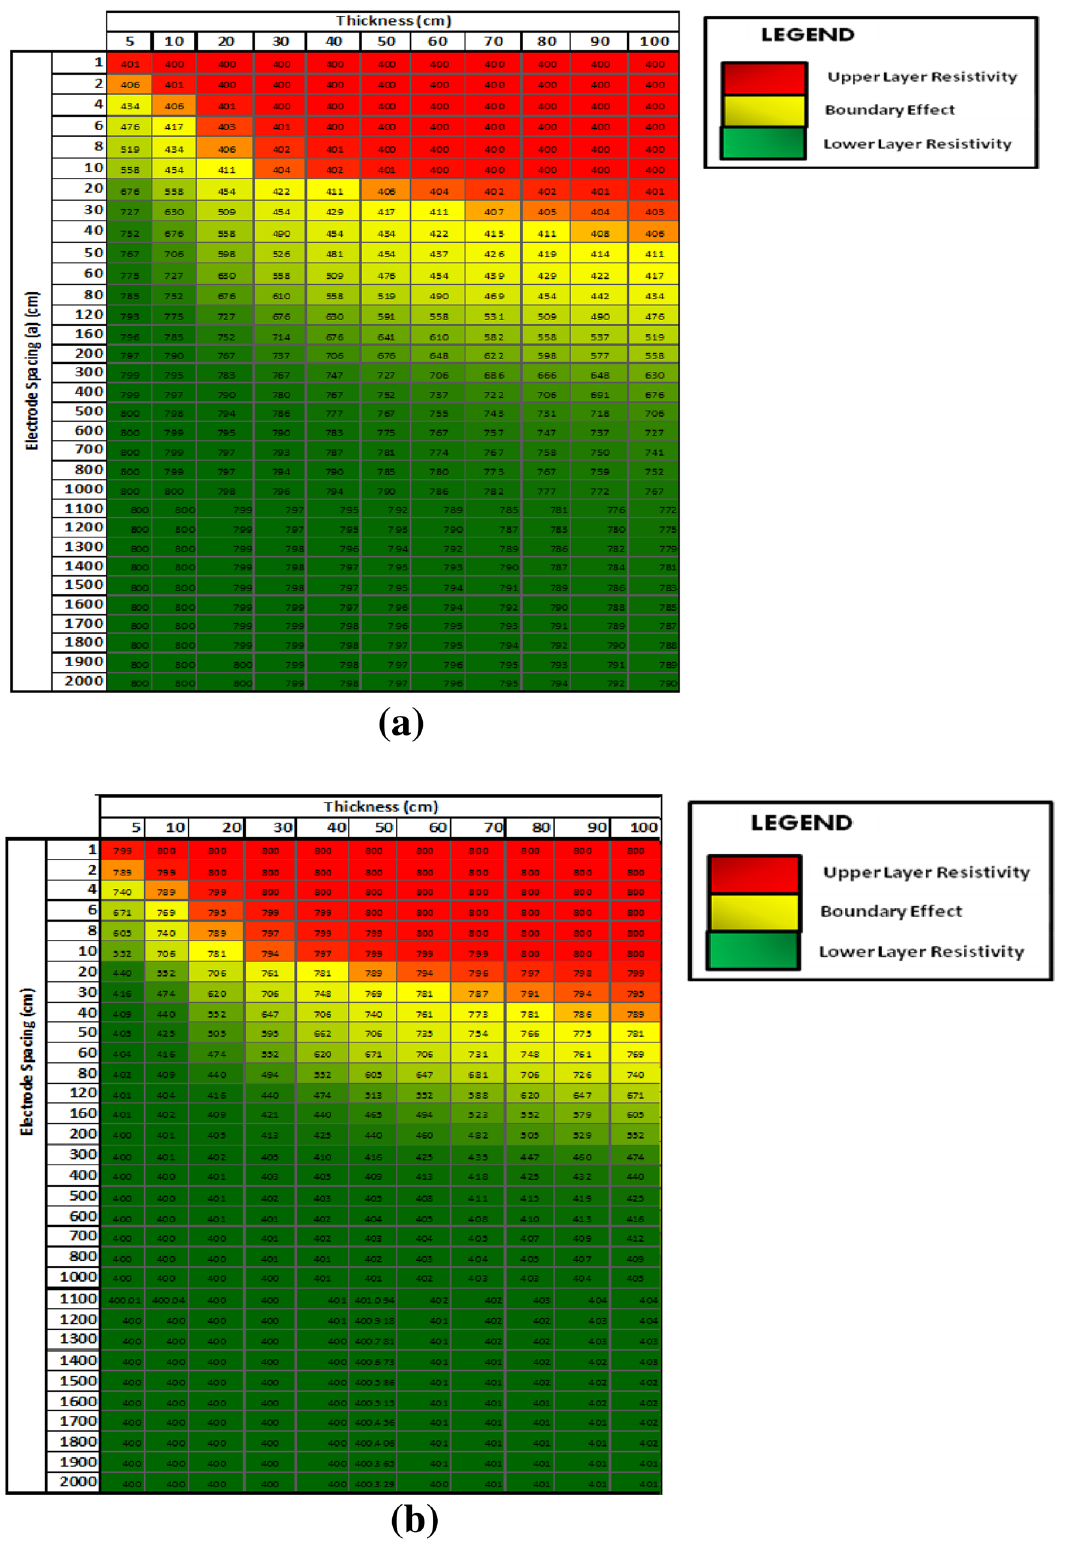
Fig. 5 a Layer sensitivity model for conductive upper layer case b Layer sensitivity model for resistive upper layer